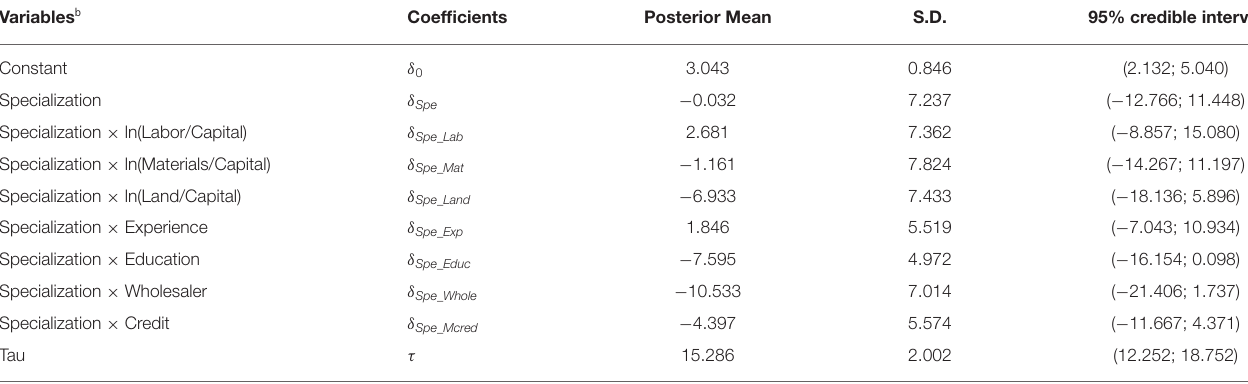
TABLE 3 | Bayesian estimates of the efficiency effect model (non-neutral specification). a